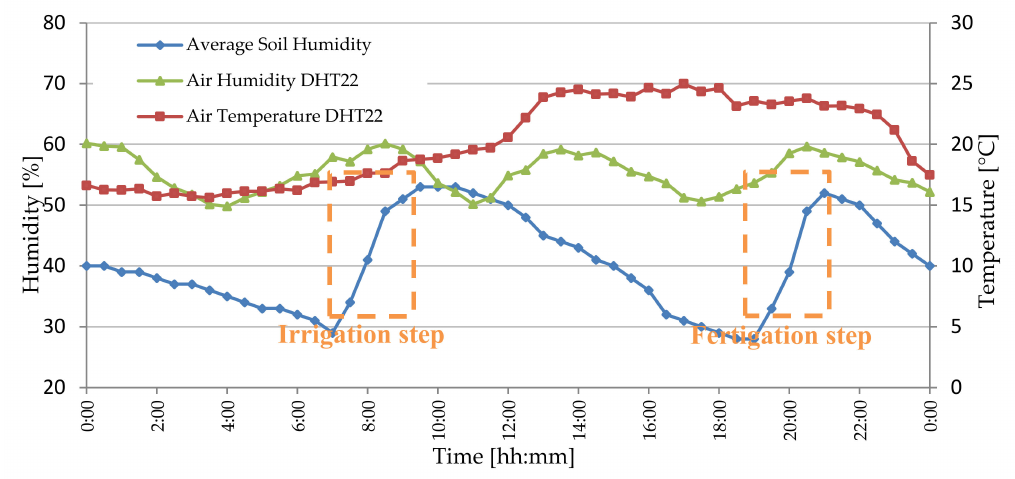
Figure 25. Soil and air humidity and air temperature temporal trends acquired by the wireless sensor network (WSN) nodes installed in a greenhouse, equipped with a centralized dehumidifier implant controlled by the data collected on-field (on 09 / 09 / 2019, Lecce,